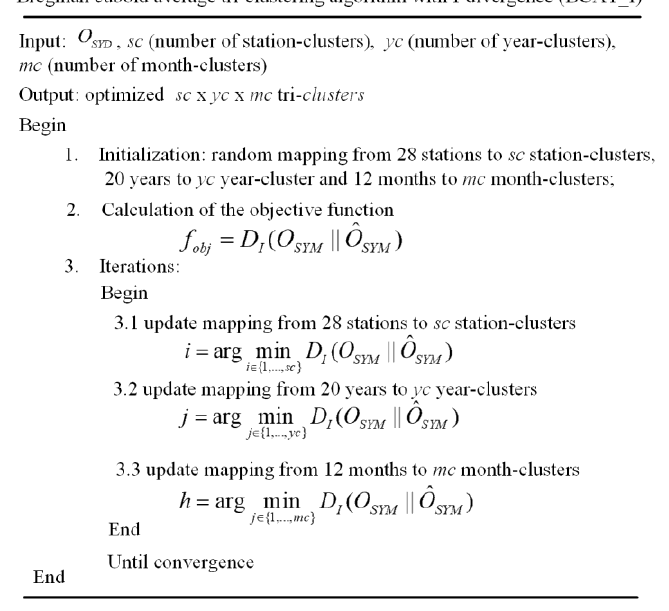
Figure 3. The optimization process of BCAT_I exemplified using Dutch monthly temperature data.